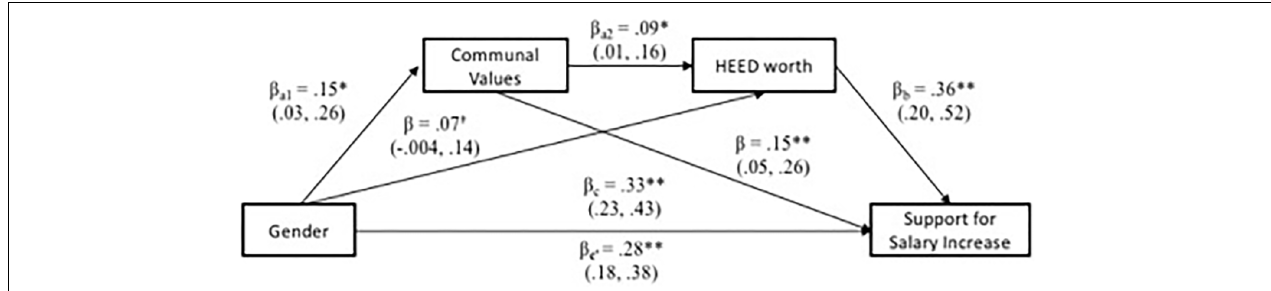
FIGURE 9 | Serial mediation model predicting support for salary increase in Study 3. ∗∗ p < 0.01, ∗ p < 0.05, † p < 0.10.